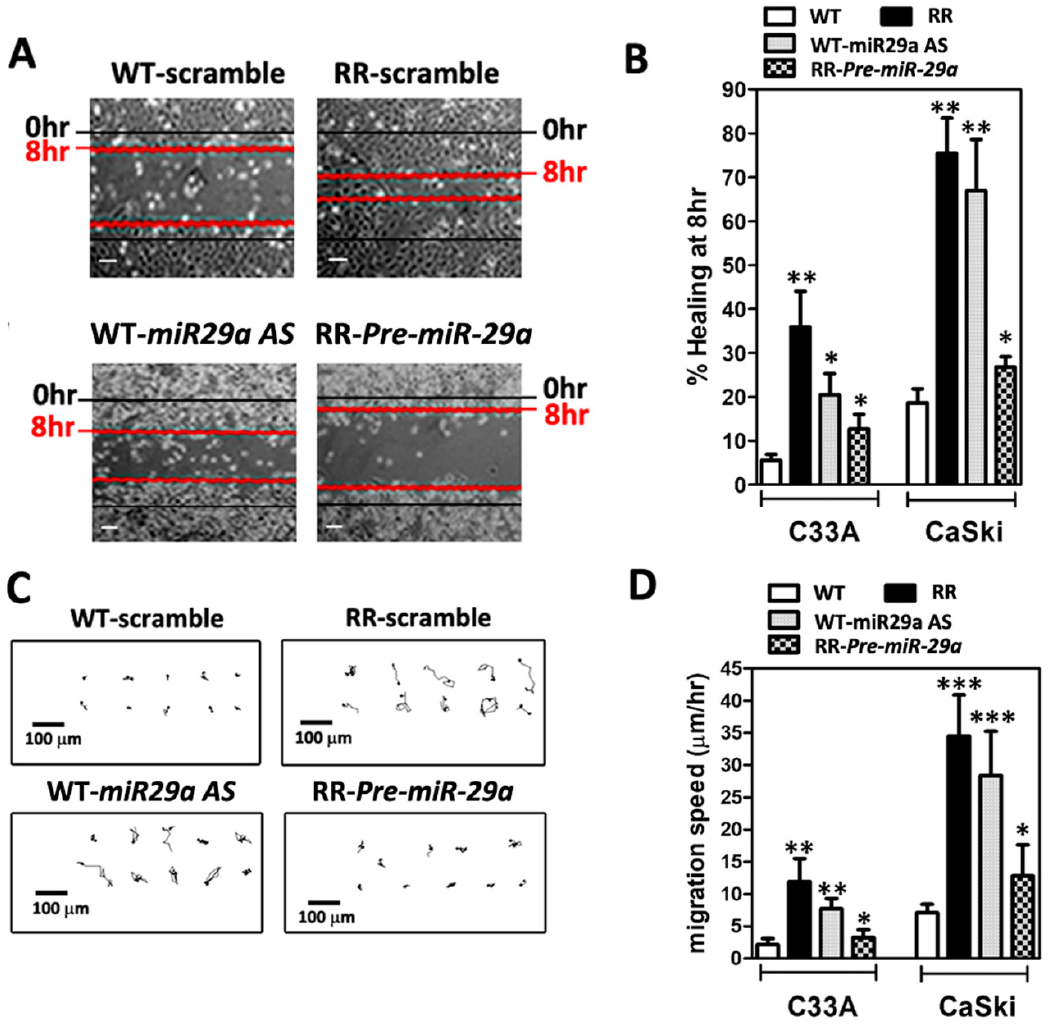
Figure 4. Radioresistant (RR) CaSki and C33A cells exhibited augmented migration in vitro, and overexpression of miR-29a effectively abrogated RR-augmented cell migration. ( A ) Representative phase-contrast micrographs depicting scratched monolayers of serum-starved WT and RR CaSki and C33A cells at 0 and 8 h. Scale bar = 100 μ m. The results of each cell were repeated at least three times, and the results were similar. ( B ) Summary of wound healing 8 h after scratching. Data are shown as mean ± SD. ( C ) Representative cell migration trace from a time-lapse recording of cell migration